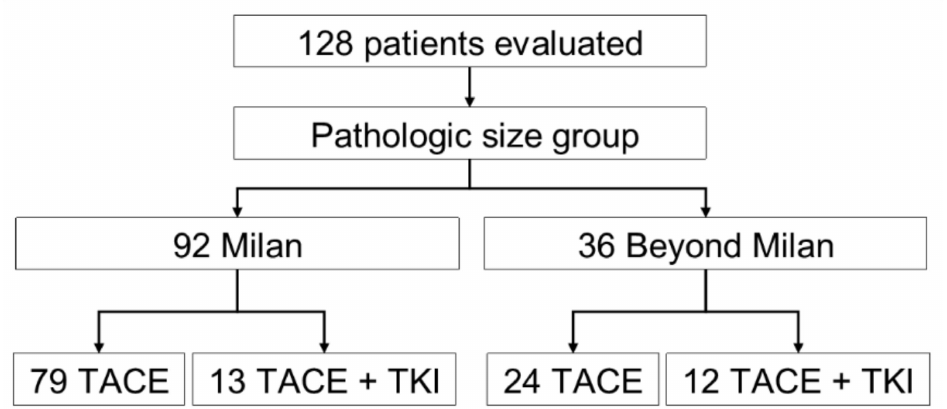
Figure 1. Flowchart of the study population, TACE, transarterial chemoembolization; TKI, tyrosine kinase